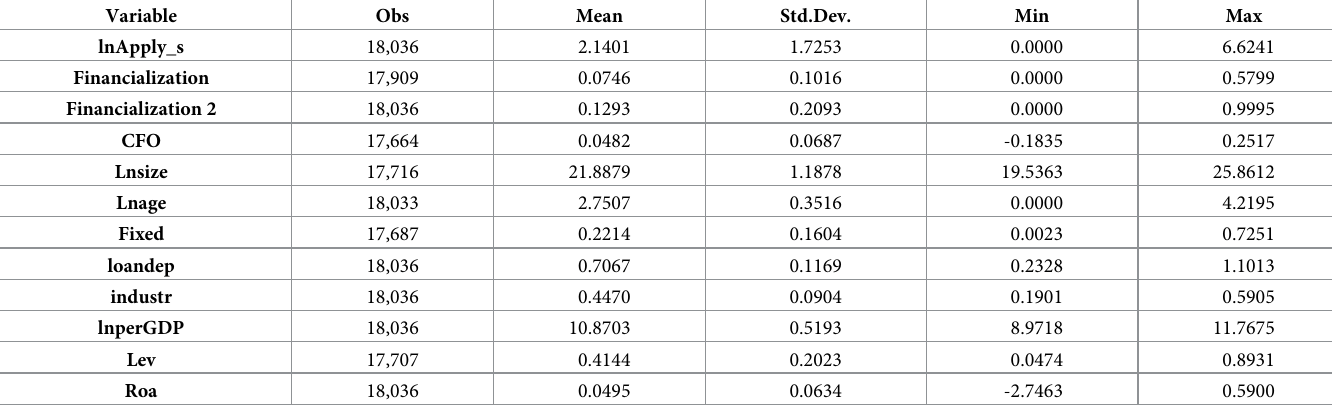
Table 2. Descriptive statistics of